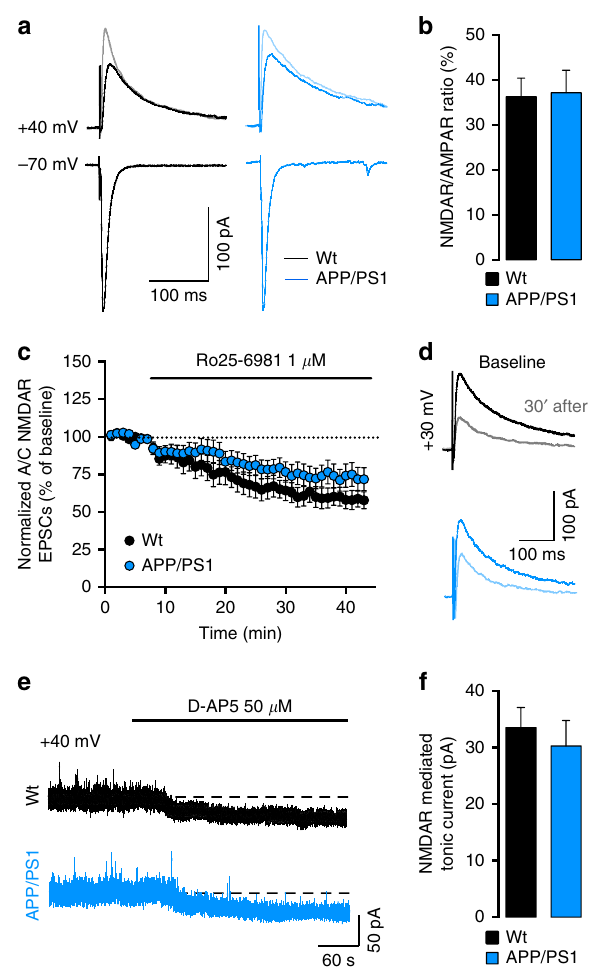
Figure 3 | Loss of A/C LTP is not associated with dysregulation of NMDAR. ( a ) A/C EPSCs were recorded at negative and positive potentials, and NMDAR-EPSCs were pharmacologically isolated with 20 m M NBQX (darker traces at þ 40mV). Traces represent the average of 40 sweeps recorded at 0.1Hz. ( b ) Mean values of NMDAR/AMPAR ratios obtained with isolated currents at (cid:2) 70mV (AMPAR) and þ 40mV (NMDAR) from wt ( n ¼ 18) and APP/PS1 mice ( n ¼ 16; P ¼ 0.894, unpaired t -test). ( c ) Summary plot of the time course of A/C NMDAR-EPSCs amplitude during the application of Ro25-698 in wt ( n ¼ 13) and APP/PS1 cells ( n ¼ 16, P ¼ 0.155, unpaired t -test). Amplitude of A/C NMDAR-mediated EPSCs was normalized to the mean amplitude of an 8min baseline period and quantification was performed after 30min of drug application. ( d ) Average traces of pharmacologically isolated (20 m M NBQX) A/C NMDAR-EPSCs obtained at a stimulation frequency of 0.1Hz during baseline and after 30min of Ro25-698 (1 m M) application (lighter traces). ( e ) Representative examples of the shift in holding current observed in CA3 PCs clamped at þ 40mV in response to D-AP5 revealing the tonic activation of extrasynaptic NMDAR at rest. AMPAR and KAR were blocked with 20 m M NBQX. ( f ) Summarizing bar graph representing the shift of inward current in wt ( n ¼ 14) and APP/PS1 cells ( n ¼ 14, P ¼ 0.573, unpaired t -test). Data calculated as the difference between the last min of baseline and the last min after a 6-min D-AP5 application. Recordings were performed in the presence of 10 m M bicuculline and 3 m M